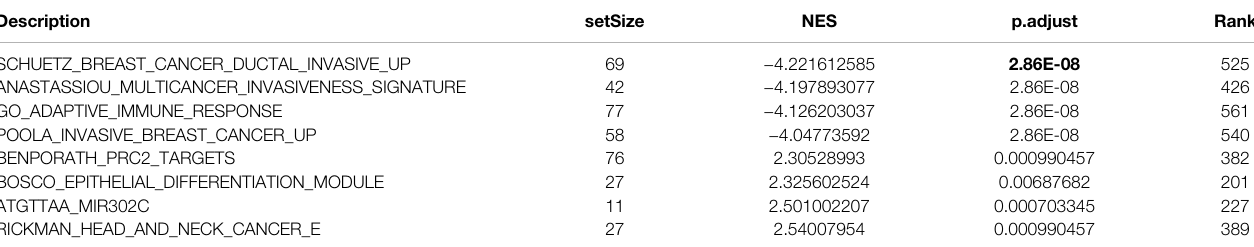
TABLE 5 | Results of GSEA enrichment analysis.